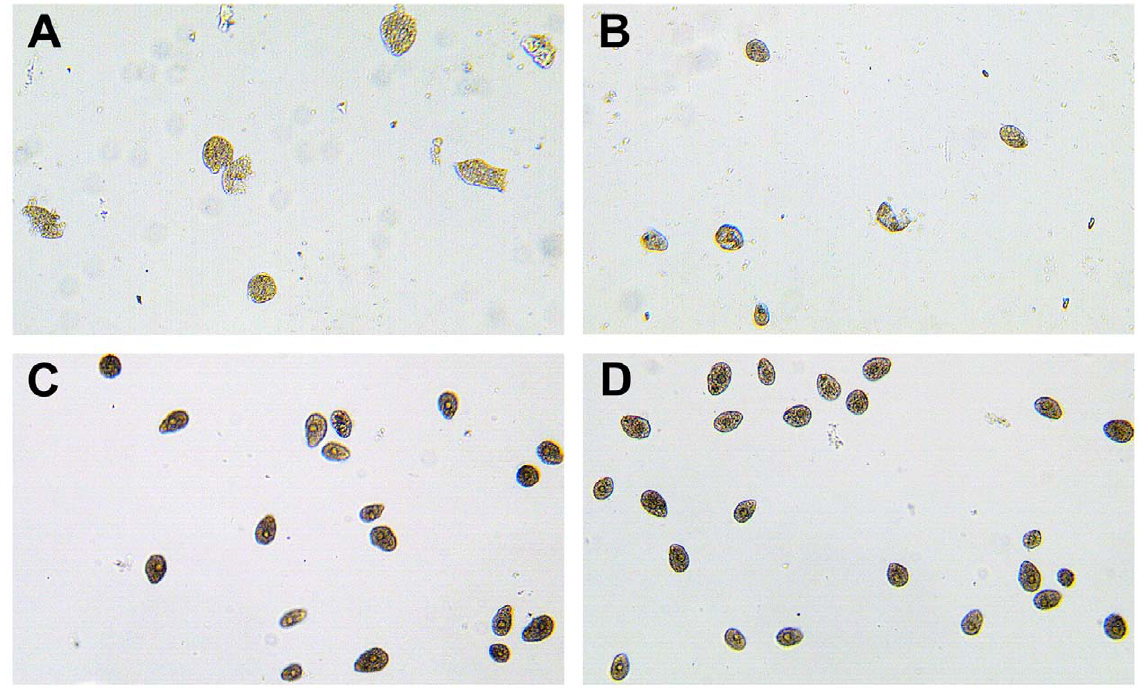
Figure 6. Morphological changes of T.thermophila cells after co-cultivation with different Aeromonas strains. T. thermophila was co- cultured with A. hydrophila XY-16 (A), A. hydrophila NJ-1 (B) and A. media NJ-8 (C) in SPP medium for 12 h before being observed under a light microscope. T. thermophila cultured in the absence of A. hydrophila (D) was used as a comparative control. Magnification 6 100.